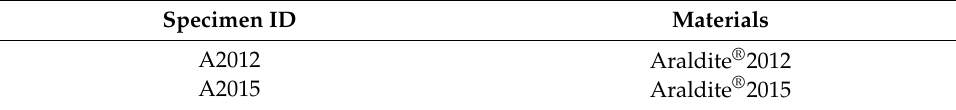
Table 1. Specimen ID and specific materials.